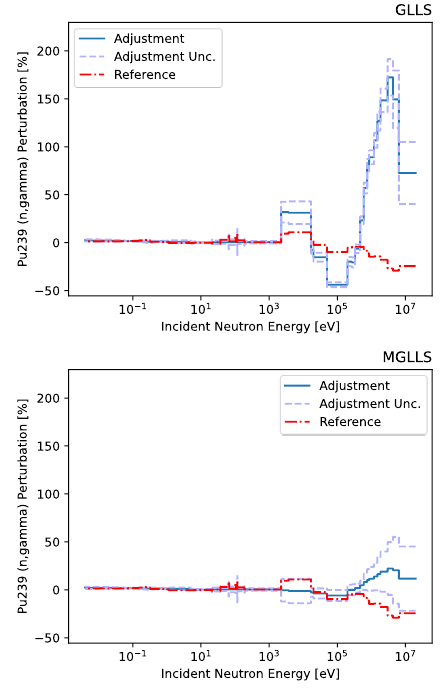
Fig. 5 Comparison of adjusted nuclear data #4